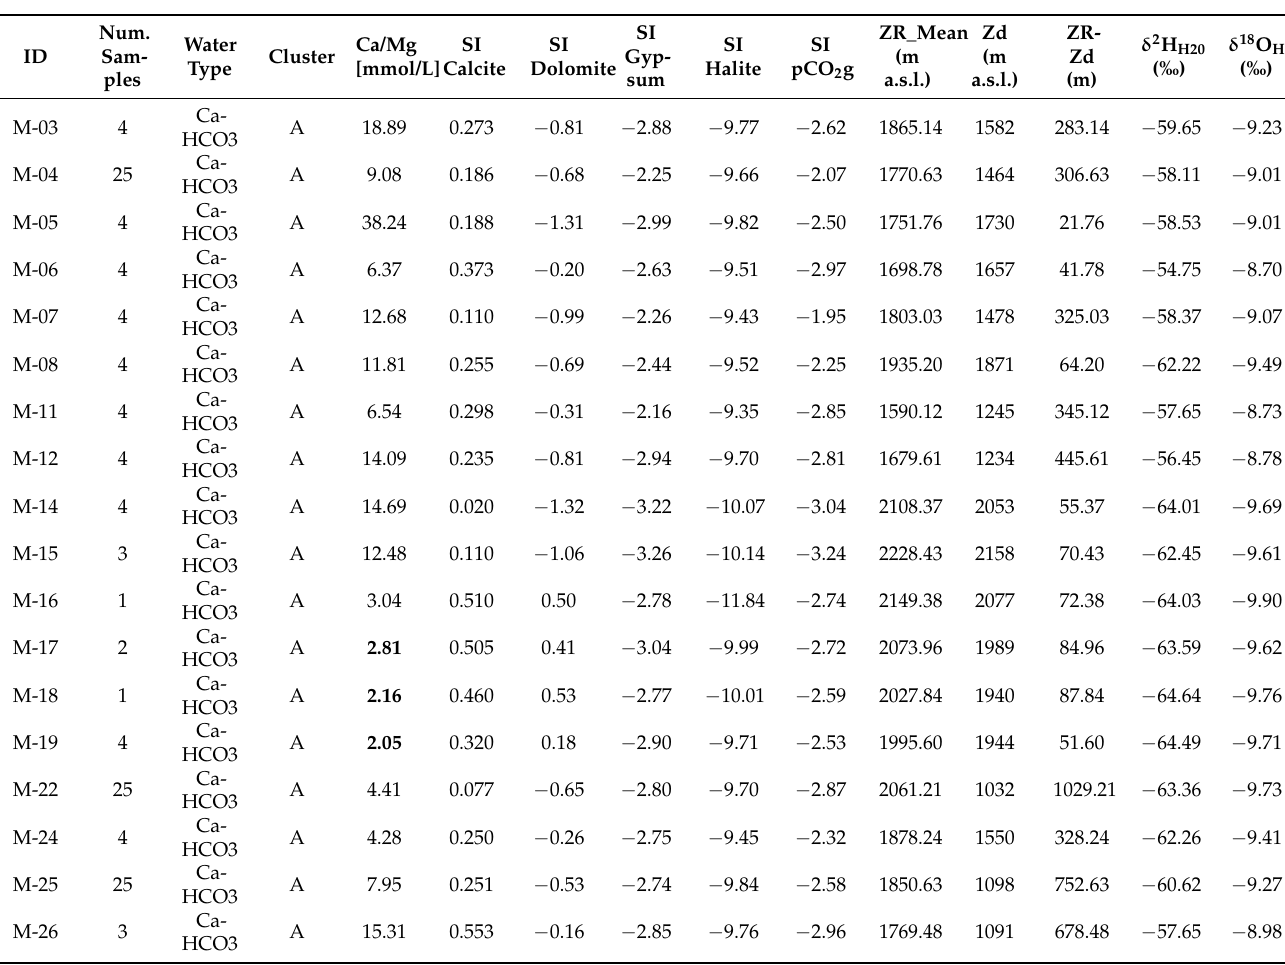
Table A3. Average values of saturation indices (SIs) relative to calcite, dolomite, gypsum, and halite, values of pCO 2 , and δ 2 H H2O , δ 18 O H2O for the 43 water springs (median values for the whole campaigns carried out from